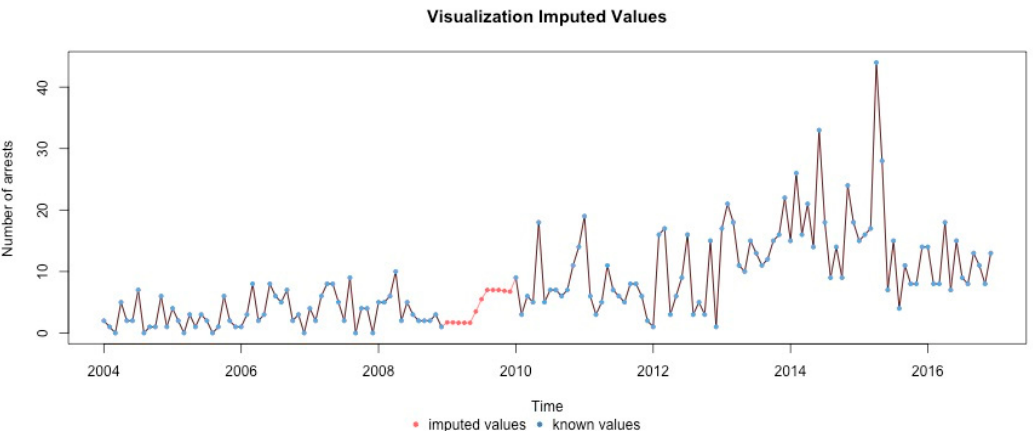
Figure A2. Methamphetamine Czech nationals arrests 2004–2016 in the Czech Republic – imputed missing values.